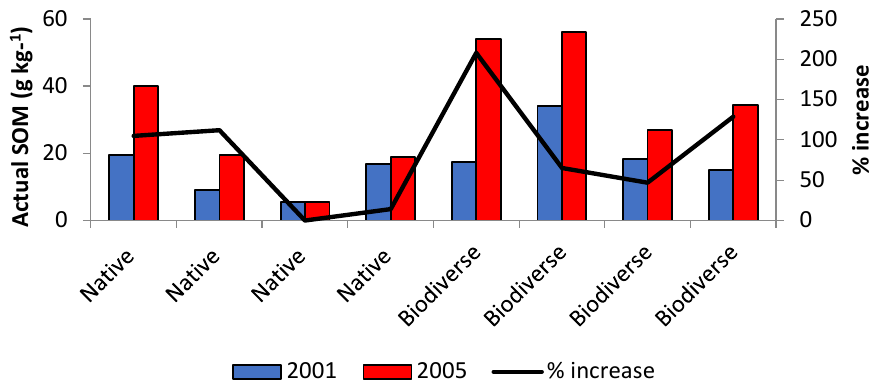
Figure 2. Variation in actual soil organic matter (SOM) at 0–20 cm soil depth, in two different pastures in Portugal, comparing data of 2001 and 2005). (Adapted from [51] Teixeira et al., 2011.)